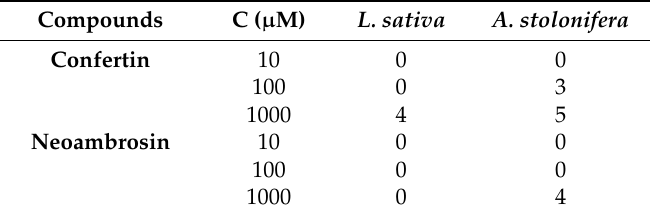
Ranking based on scale of 0 to 5. 0 = no effect. 5 = no growth.